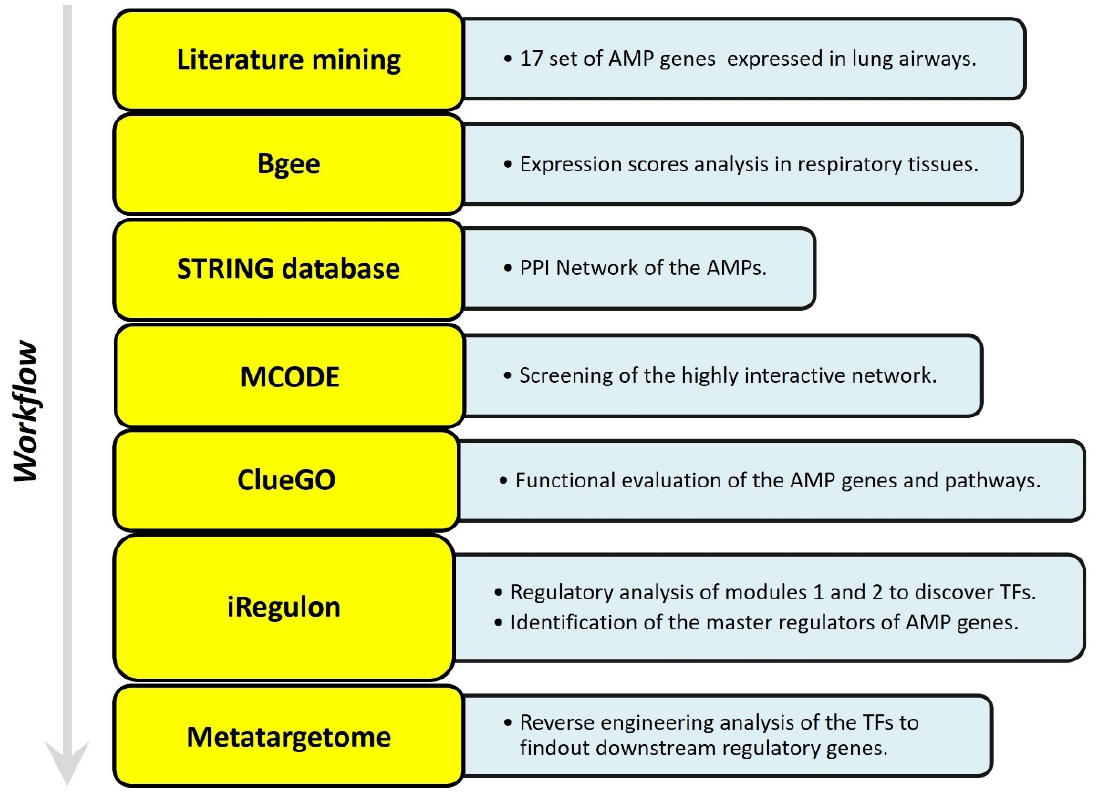
Figure 2. Adopted work-flow to study the gene expression profile of HDPs in lung airways habitat, and construction of PPI network.